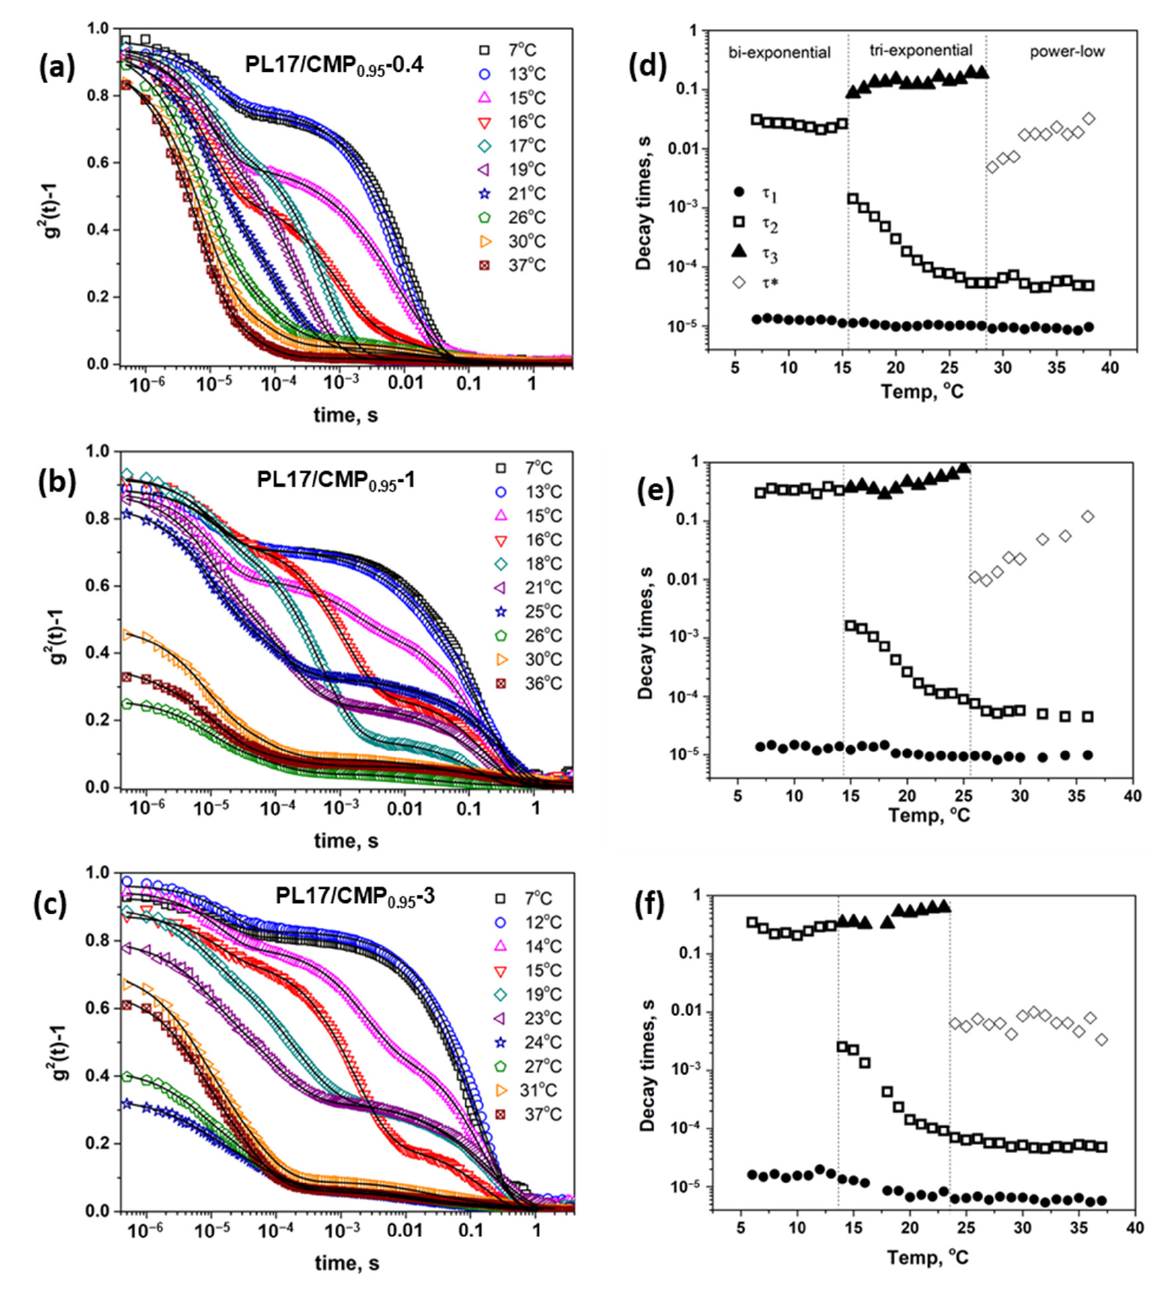
Figure 11. Intensity autocorrelation function for PL17/CMP 0.95 -0.4 ( a ), PL17/CMP 0.95 -1 ( b ) and PL17/CMP 0.95 -3 ( c ). The lines are the fits. Temperature dependence of the decay times for the corresponding systems ( d – f ).